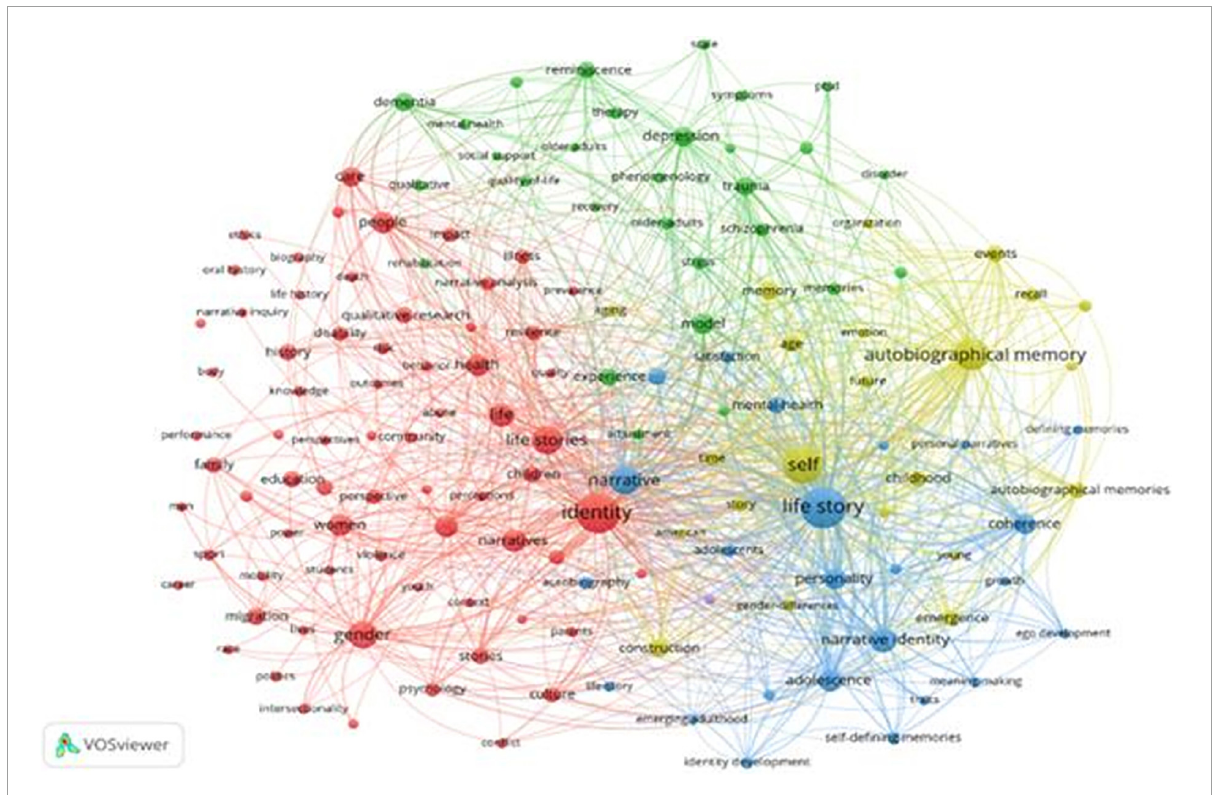
FIGURE3 Keyword co-occurrence